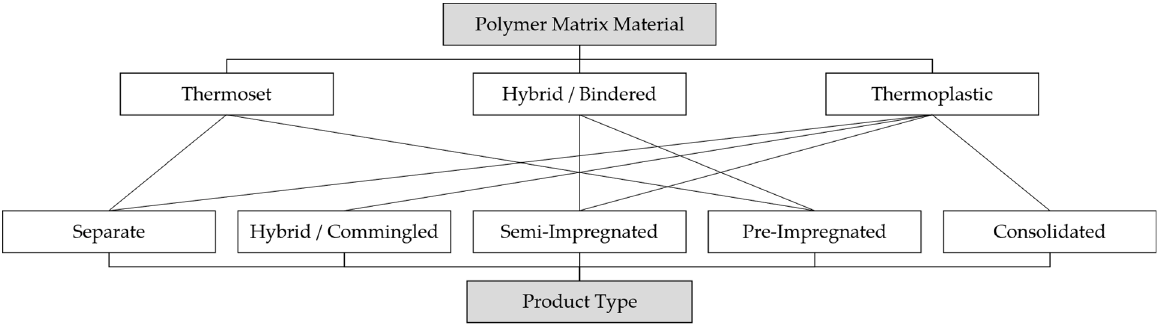
Figure 2. Considered polymer matrix materials and types of semi-finished products, as well as their availability on the market as indicated by the links. availability on the market as indicated by the